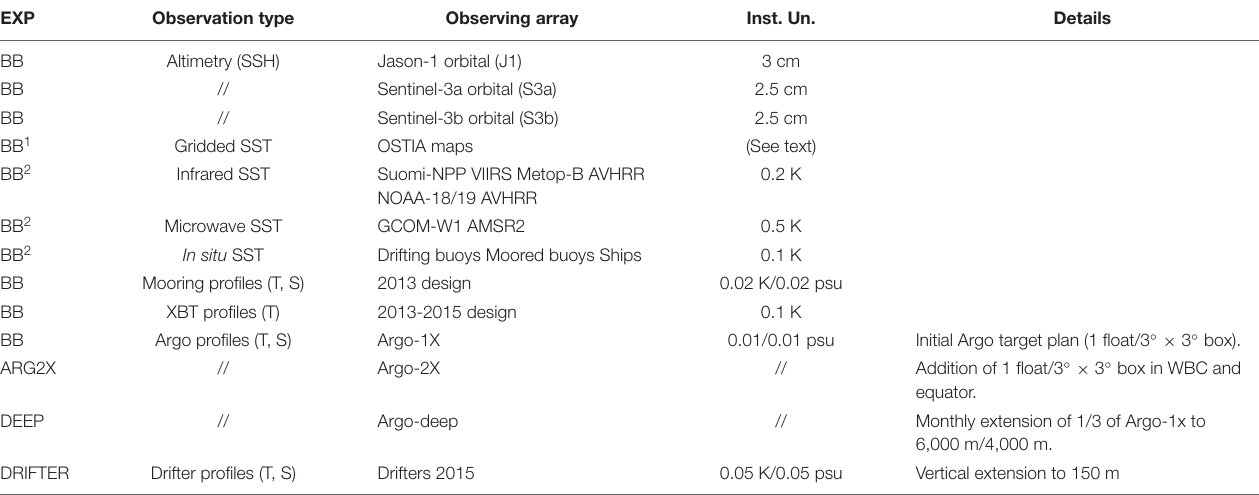
TABLE 3 | Observation types and observation systems, which have been used for subsampling the NR at the space and time location of each observation and assimilated in the OSSEs. EXP Observation type Observing array Inst.